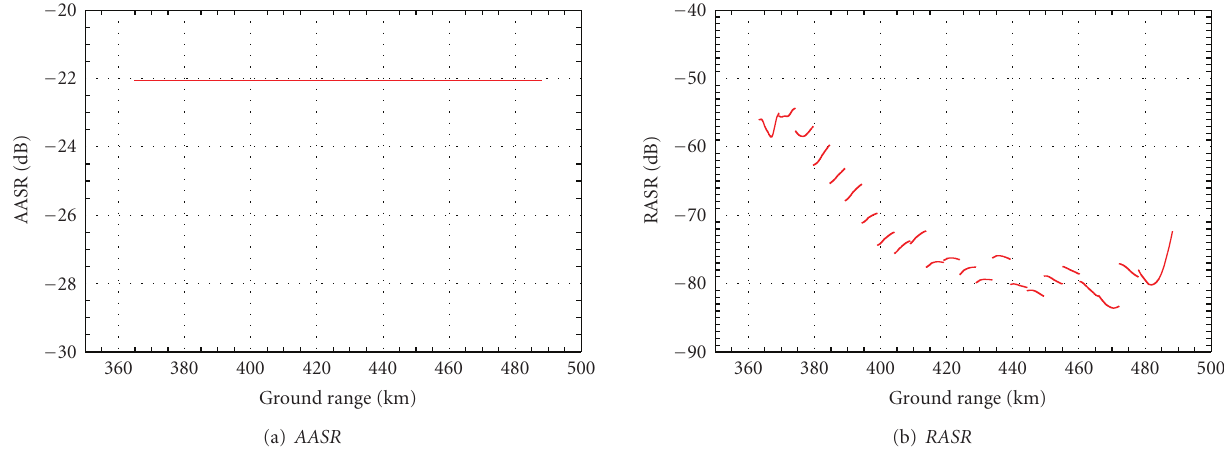
Figure 18: Ambiguities versus ground range for the reflector system.